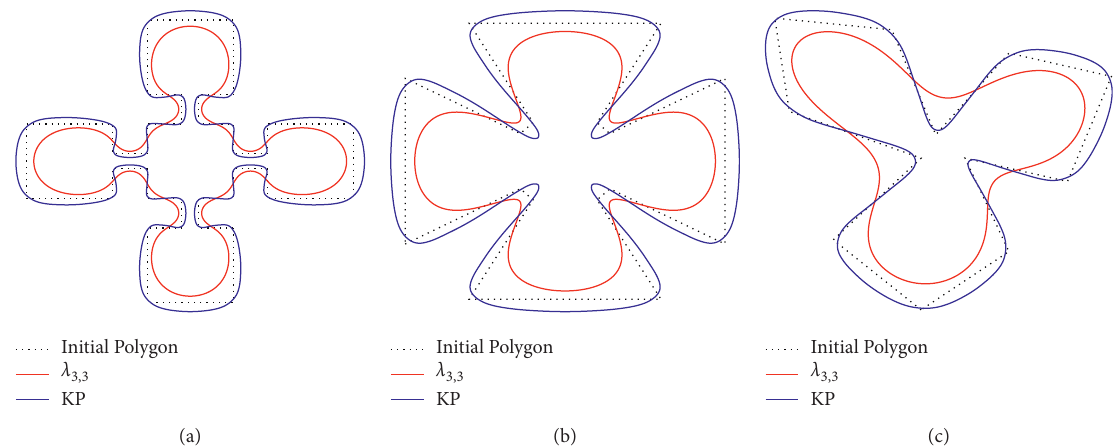
Figure 2: (a–c) Comparison of limit curves for close polygons produced by 4-point schemes λ